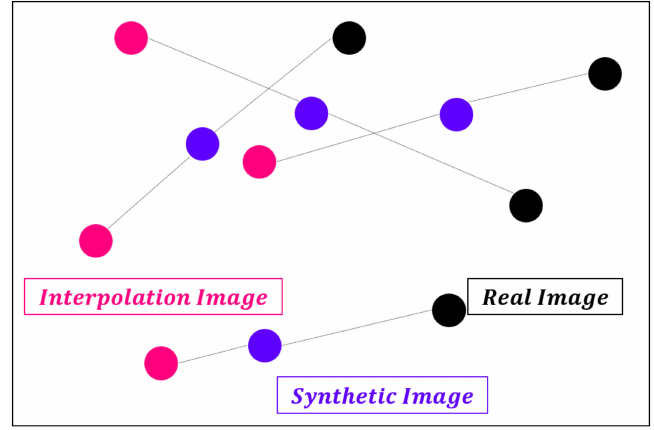
Figure 2. Interpolation between images.